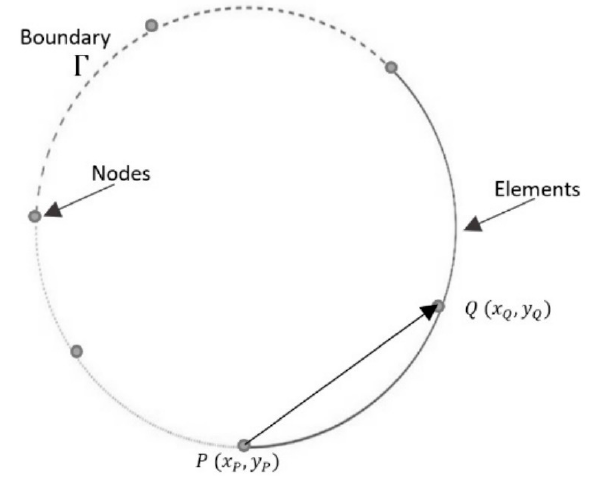
Figure 2. Nodes and elements using in the conventional BEM.